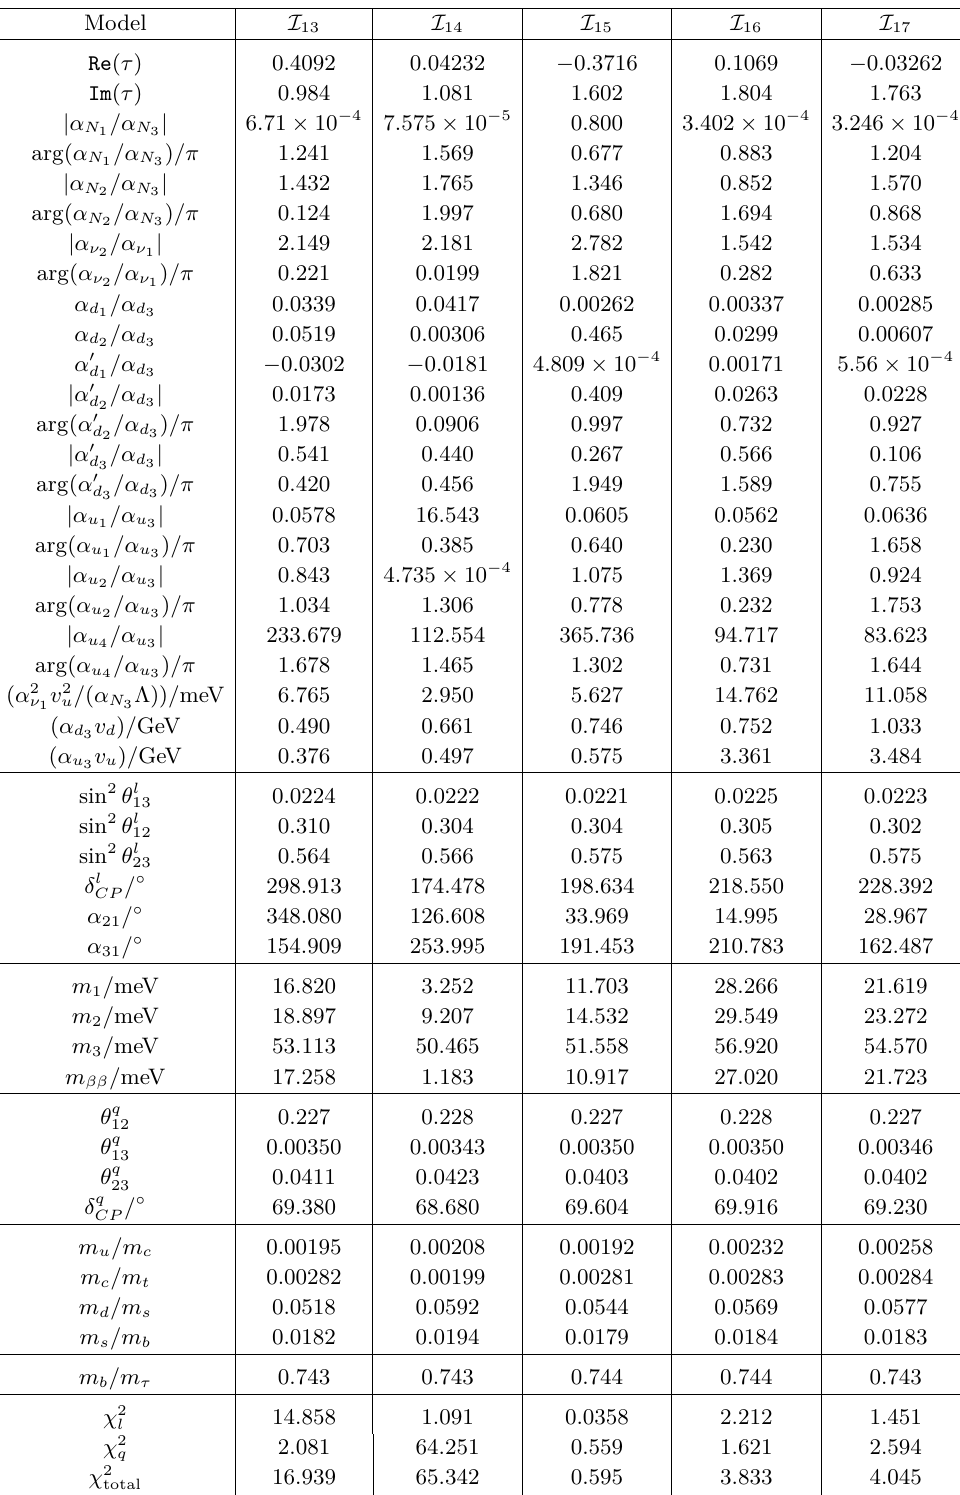
Table 7 . The best fit values of the free parameters and the corresponding predictions for lepton and quark mixing parameters and fermion masses for the phenomenologically viable models of Type-I (continuation of table